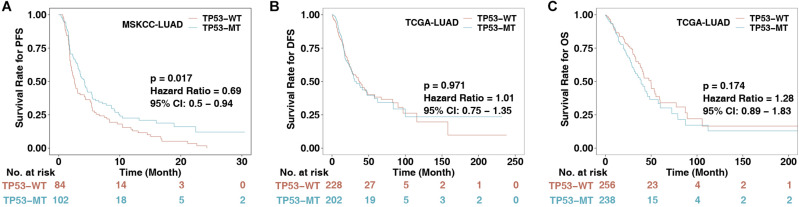
The association between TP53 status and clinical data. (A) KM survival analysis evaluated the relationship between TP53 status and PFS of patients in the MSKCC-LUAD cohort, p < 0.05. (B) Relationship between TP53 status and DFS of patients in the TCGA-LUAD cohort. DFS, disease-free survival. (C) Relationship between TP53 status and OS of patients in the TCGA-LUAD cohort. OS, overall survival. The log-rank test was used for a two-sided test, and P < 0.05 was regarded as significantly different.